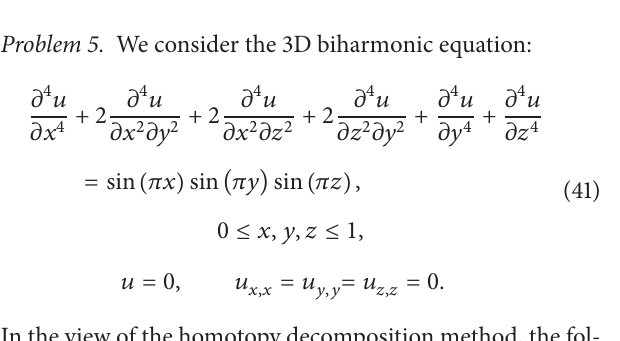
Figure 3: Analytical solution.